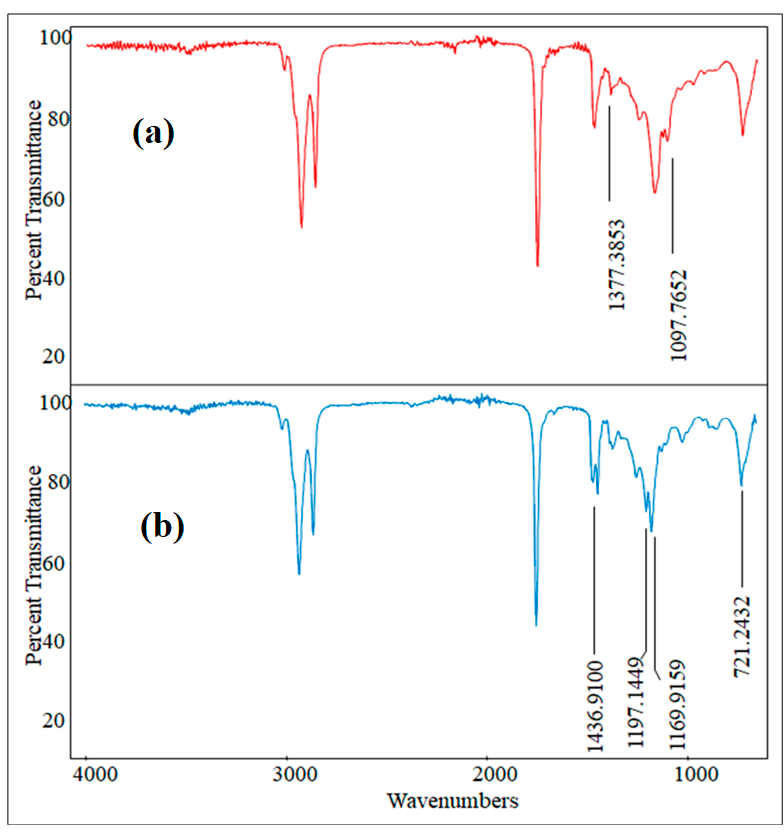
Figure 10. FTIR spectra of ( a ) E. sativa oil, ( b ) biodiesel from E. sativa oil. Table 3. FAME composition of biodiesel from E. sativa